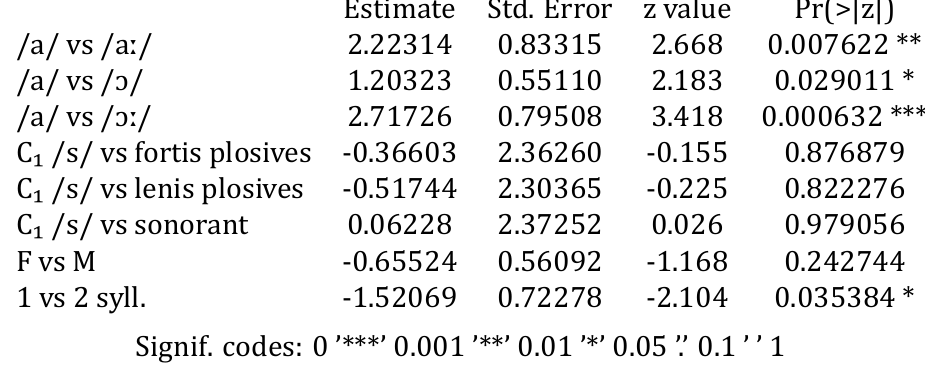
Table A.12: Pre-aspiration occurrence of C₂ /s/ as a dependent variable